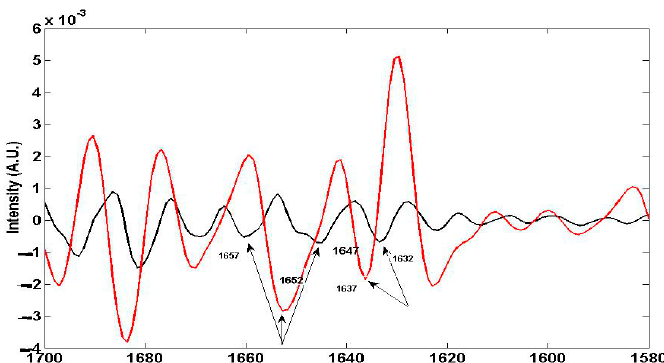
Figure 7. Second derivative FTIR spectra of Amide I bands in Vicia faba roots for the As exposure in June for the same sample of Figure 6. For the July exposure, the FTIR spectra are highly comparable. The black spectrum is the control samples, and the red spectrum is the exposed sample. The arrows show the transitions between the beta sheet (1632 cm − 1 ) with the appearance of random coil (1637 cm − 1 ) and molecular rearrangements within the alpha helix structures in the 1645 to 1660 cm − 1 range. The non-specific effects of As consist of a denaturation of proteins caused by hydrogen bond transitions and protein unfolding, involving the Amide I and Amide II bands of proteins [25–29]. As shown in Figure 7, this transition/denaturation is clearly linked to the modification of the β -sheet band at 1632 cm − 1 present in the control sample and absent in the exposed sample. In fact, in the exposed samples we observe the presence of a new band, the random coil band, present at 1637 cm − 1 [25].